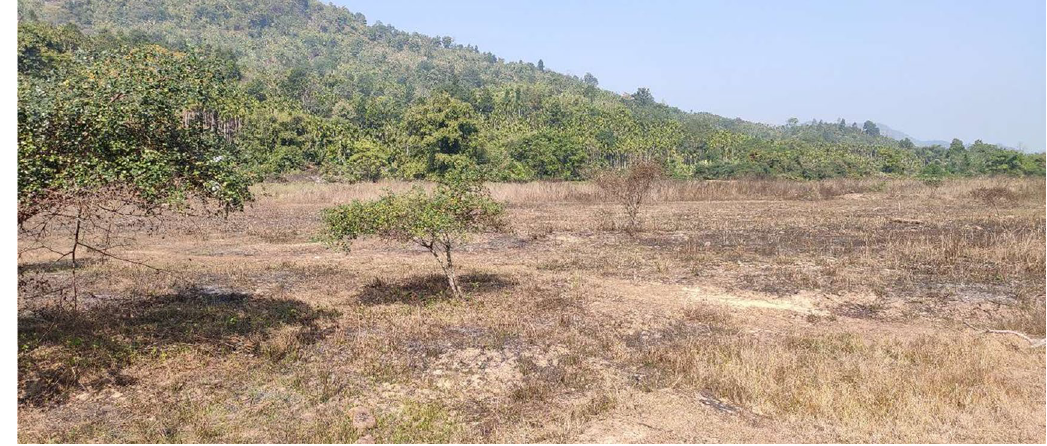
Fig. 9 Highly erodible bare ground on Bandaraja Hill of the lower Kulsi basin (image collected by the author from the field)